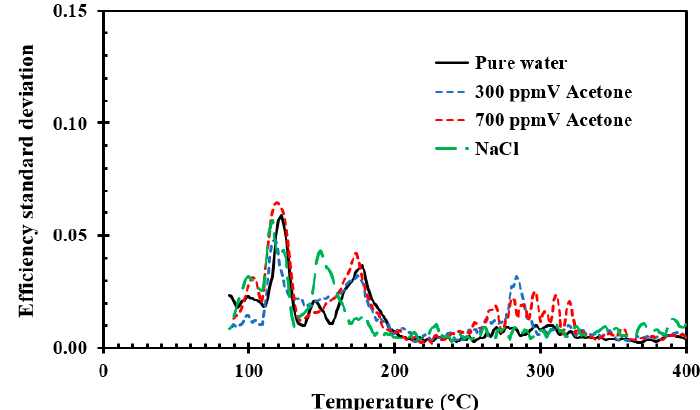
Figure 21. Comparison of cooling efficiency standard deviation for horizontal orientation at 25 cm impingement height and speed 2.2 m/s.